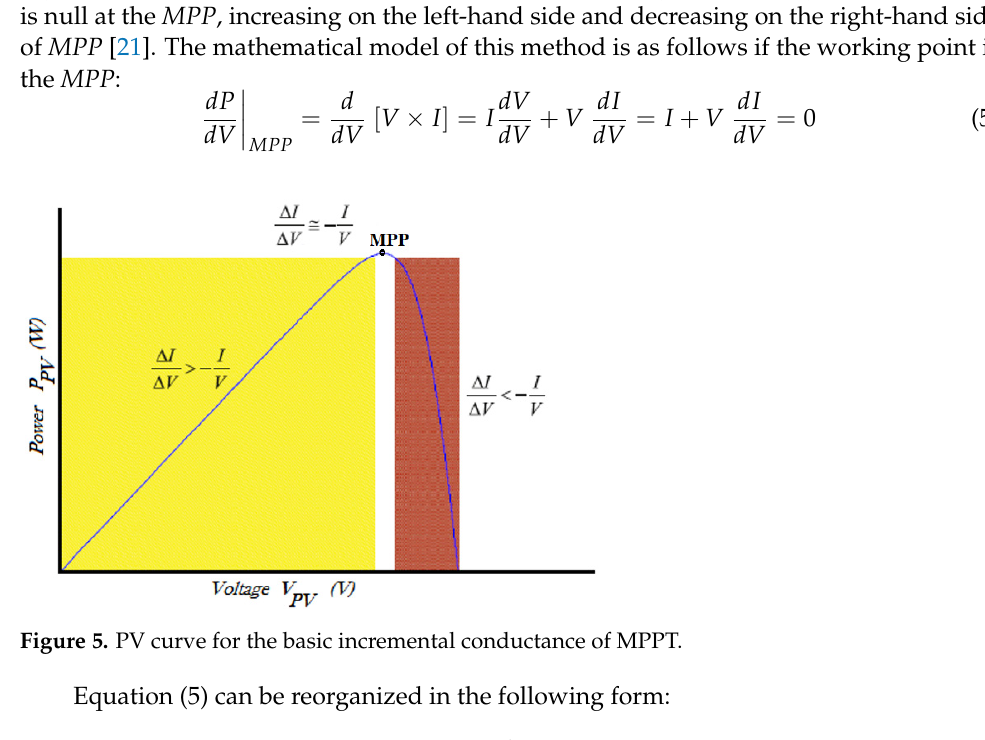
Figure 6. The basic flow chart based on MPPT incremental conductance technique. 3.4. DC/AC Inverter Controller The proposed scheme of inverter control is shown in Figure 7. The main objective is performed to set the DC-link voltage, inject real power control, and make the power factor equal to one at PCC. This control is helpful for its decoupled control ability and quick dynamics [22].